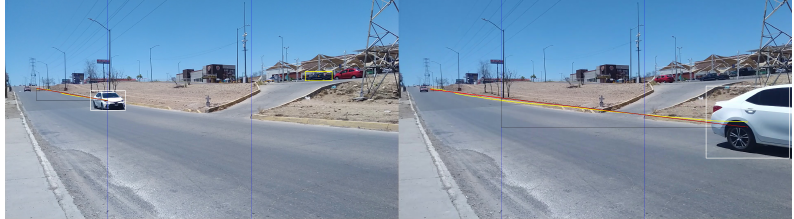
Figure 11. An invalid